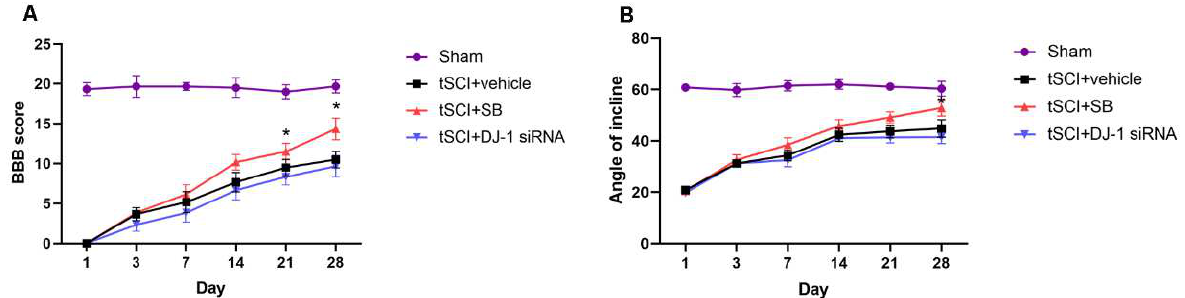
Figure 5. Effect of DJ-1 on neurological function. ( A ). The Basso, Beattie, and Bresnahan (BBB) scores were higher in the t-SCI + SB group at 21 and 28 days. ( B ). The angle of the incline in the inclined plane test (IPT) was bigger in the t-SCI + SB group at days 28 post-injury. n = 6 for each group . * p < 0.05 vs. t-SCI + vehicle